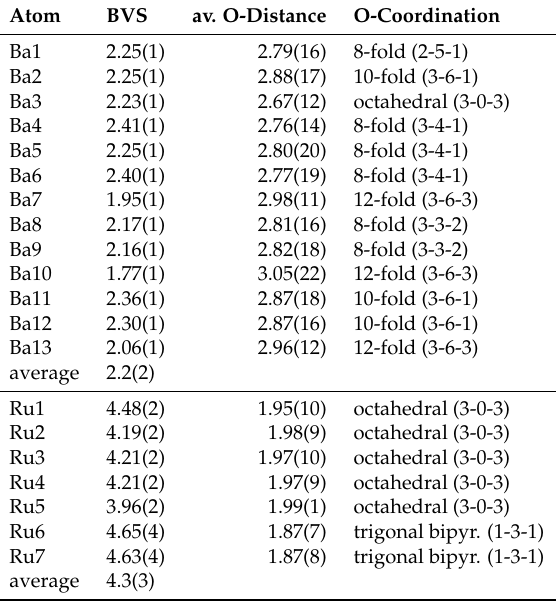
Figure 5. ( a , b ) represent the Ru oxygen layer ’A3’ shown in Figure 4. Accordingly, ( c , d ) represent the Ru oxygen doublelayer of type ’B2’. Green/white spheres: Ru-/Ba-ions, blue spheres: 99.9% probability ellipsoids for the oxygen ions. In ( a , c ) the RuO 5 and RuO 6 polyhedra are shown wheras the Ru-Ba-polyhedra are shown in ( b , d ). Table 5. Bond valence sums (BVS) for Ba and Ru ions together with their oxygen coordination. Parameters were taken from Ref. [24]. The values in the brackets indicate the number of the of oxygen ions that are (i) distinctly below, (ii) roughly within and (iii) clearly above the plane of the Ru ions (that is perpendicular to the b -axis) for a certain